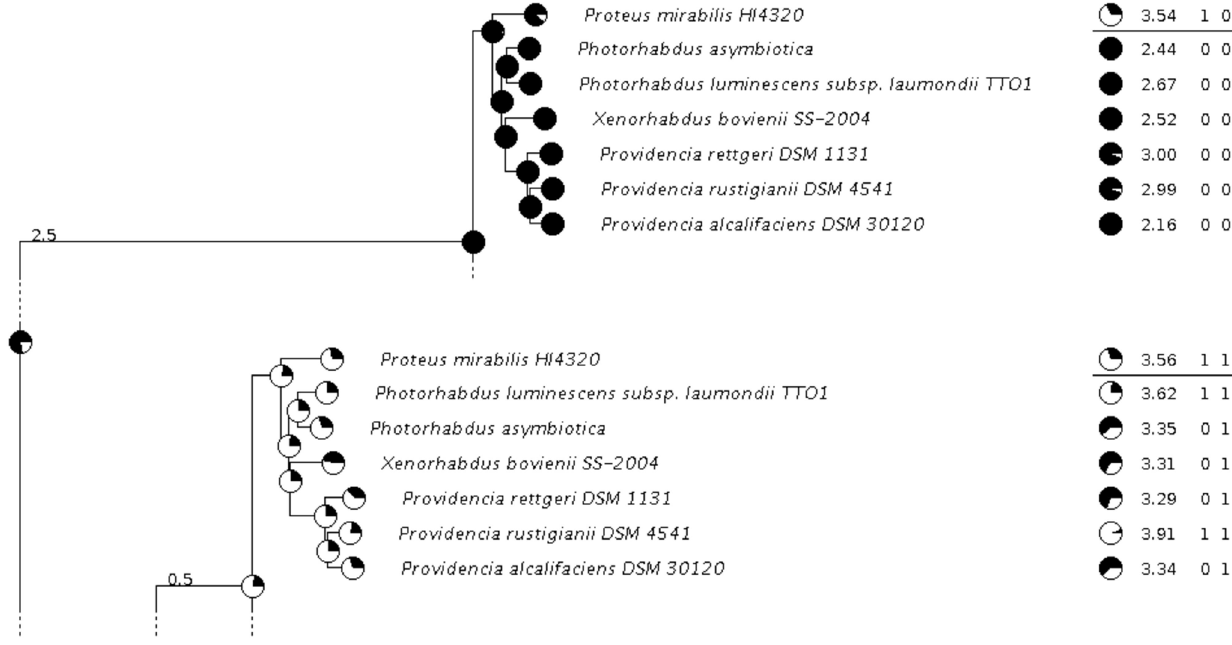
Figure 6. The results of tHMM for the TFBS reconstruction of the AsnB (L-asparaginase) tree. Notation as in Fig. 5. The score values are Z- scores.